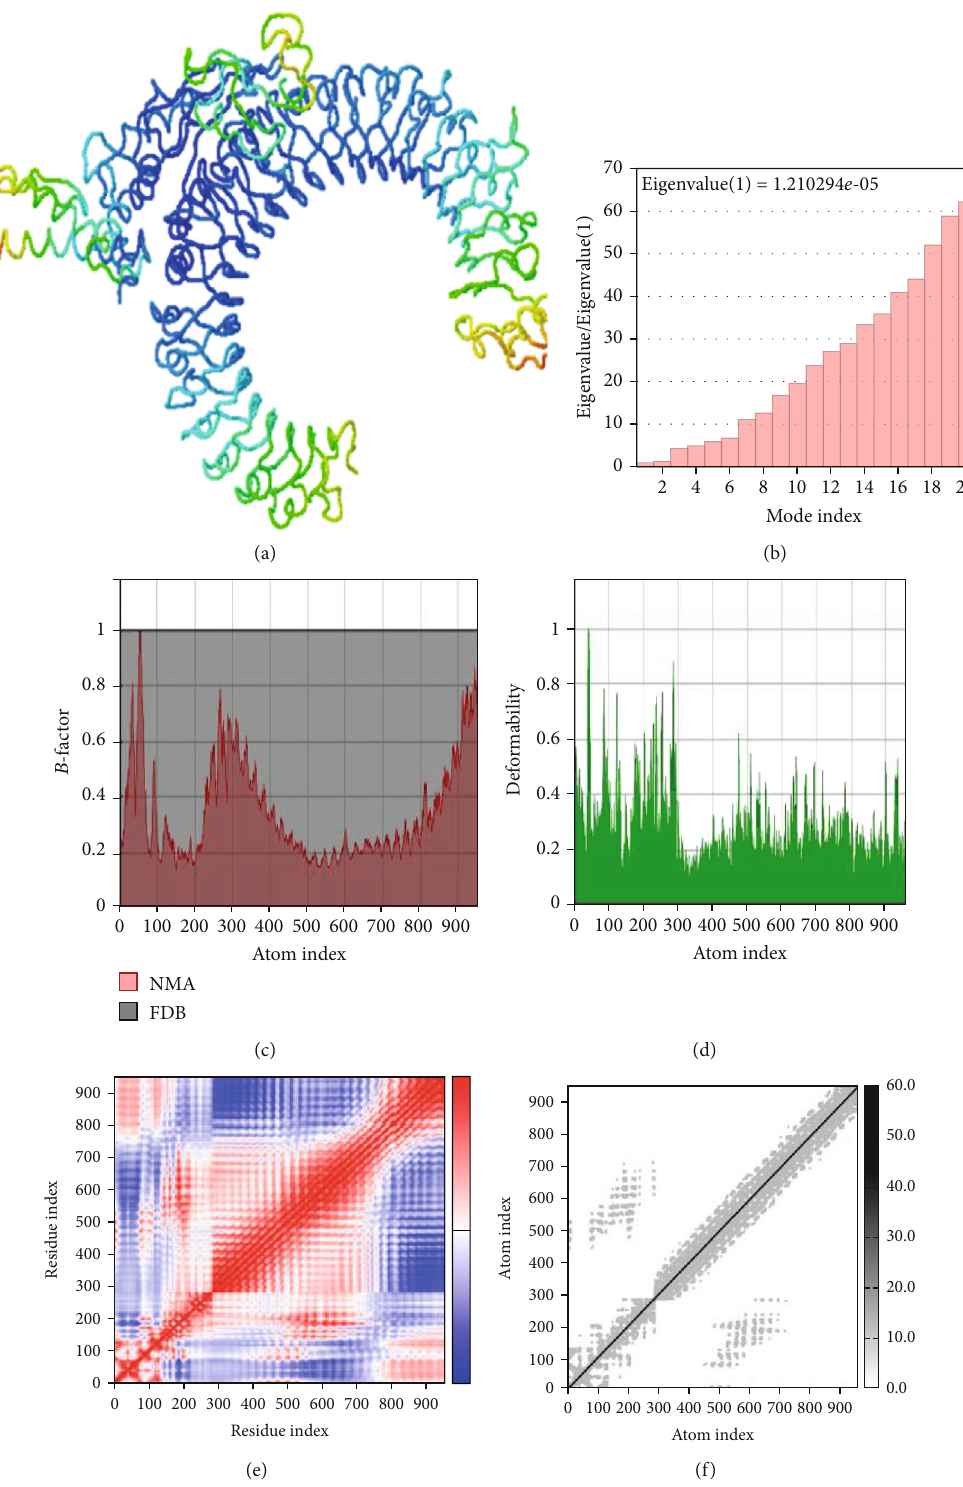
Figure 4: Normal mode analysis of the vaccine-TLR3 complex. The structural strength of re fi ned protein-protein complex was analyzed as per generated graphs: mobility (a), eigenvalue vis-à-vis modes (b), B -factor vis-à-vis atoms (c), deformability vis-à-vis atoms (d), covariance vis-à-vis residue (e), and elastic network vis-à-vis atoms